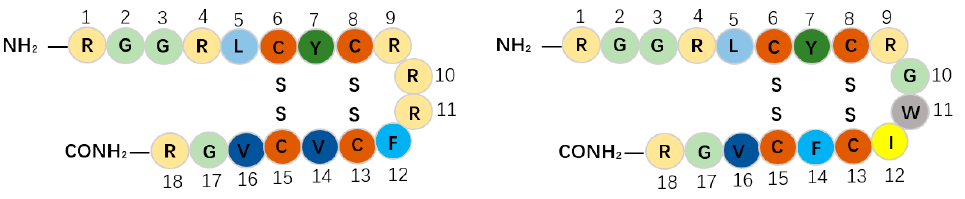
Figure 3. Sequences of PG-1 and PG-4. The same amino acids are represented by the same color. PG-4 substitutes a phenylalanine for a valine at position 14, and their sequences are different in the β -turn.